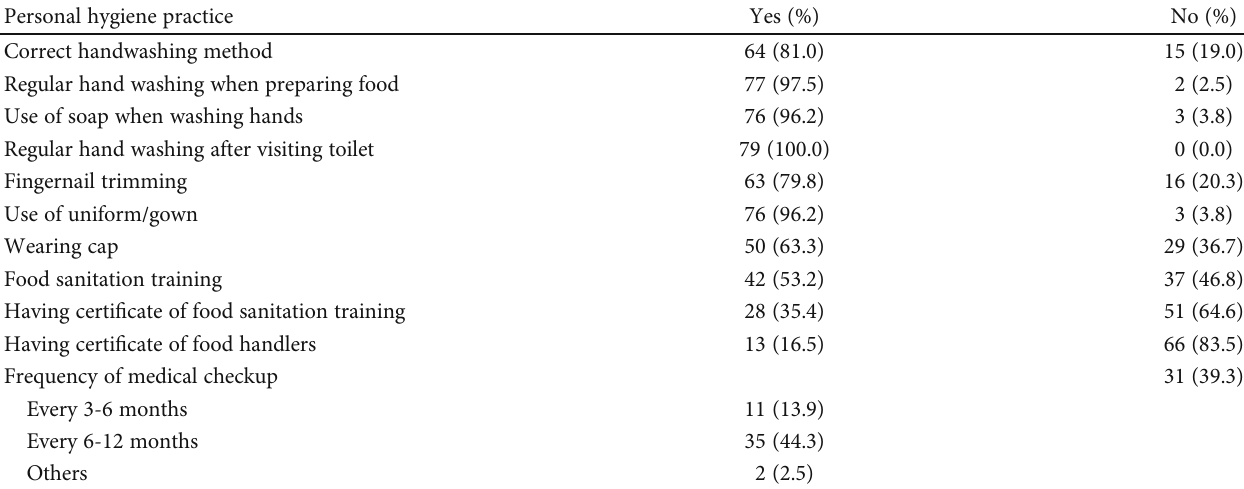
Table 3: Personal hygiene among beverage and food handlers at RSU canteens ( n = 79